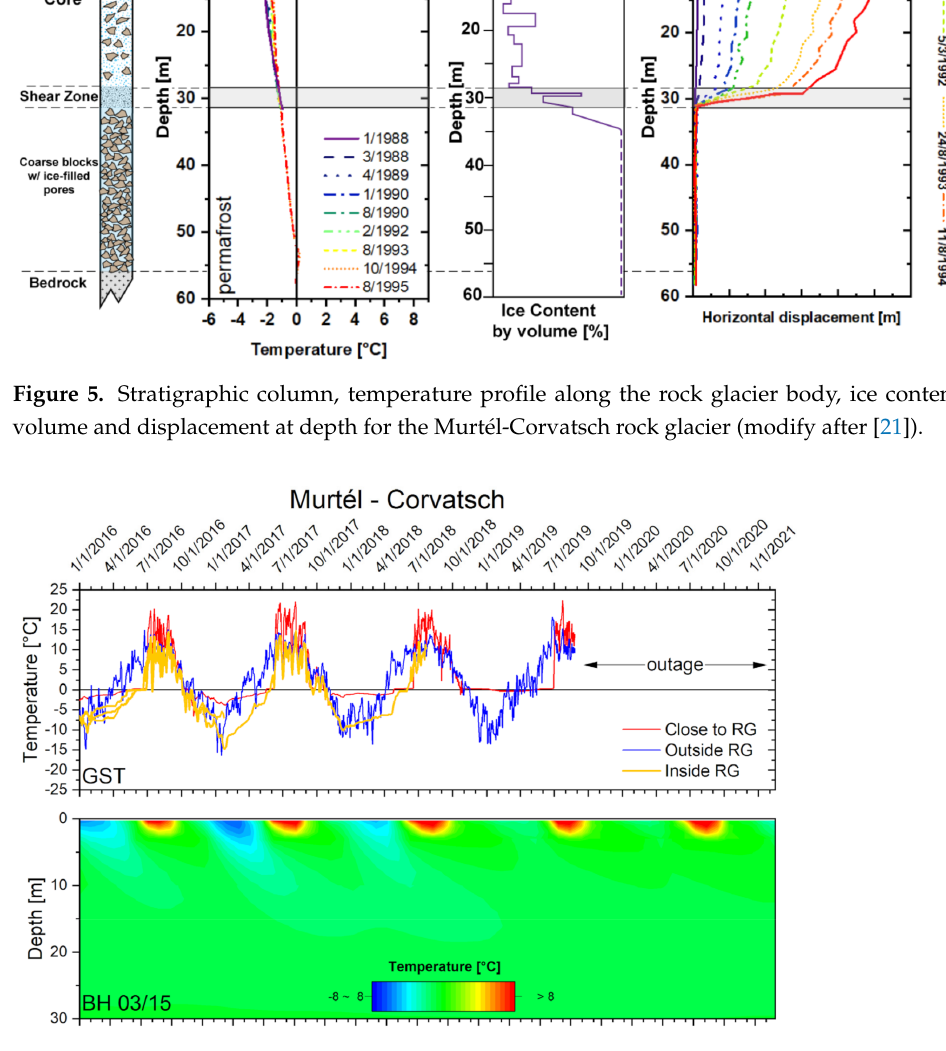
Figure 6. Ground Surface Temperature (GST) and temperature profile for the Murt è l-Corvatsch rock glacier. Data source: Swiss Permafrost Monitoring Network